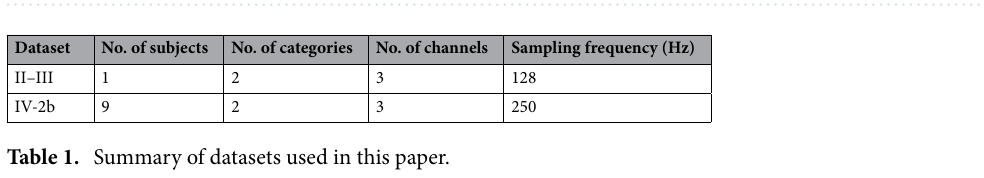
Figure 1. Block diagram of the proposed method for MI EEG classification.